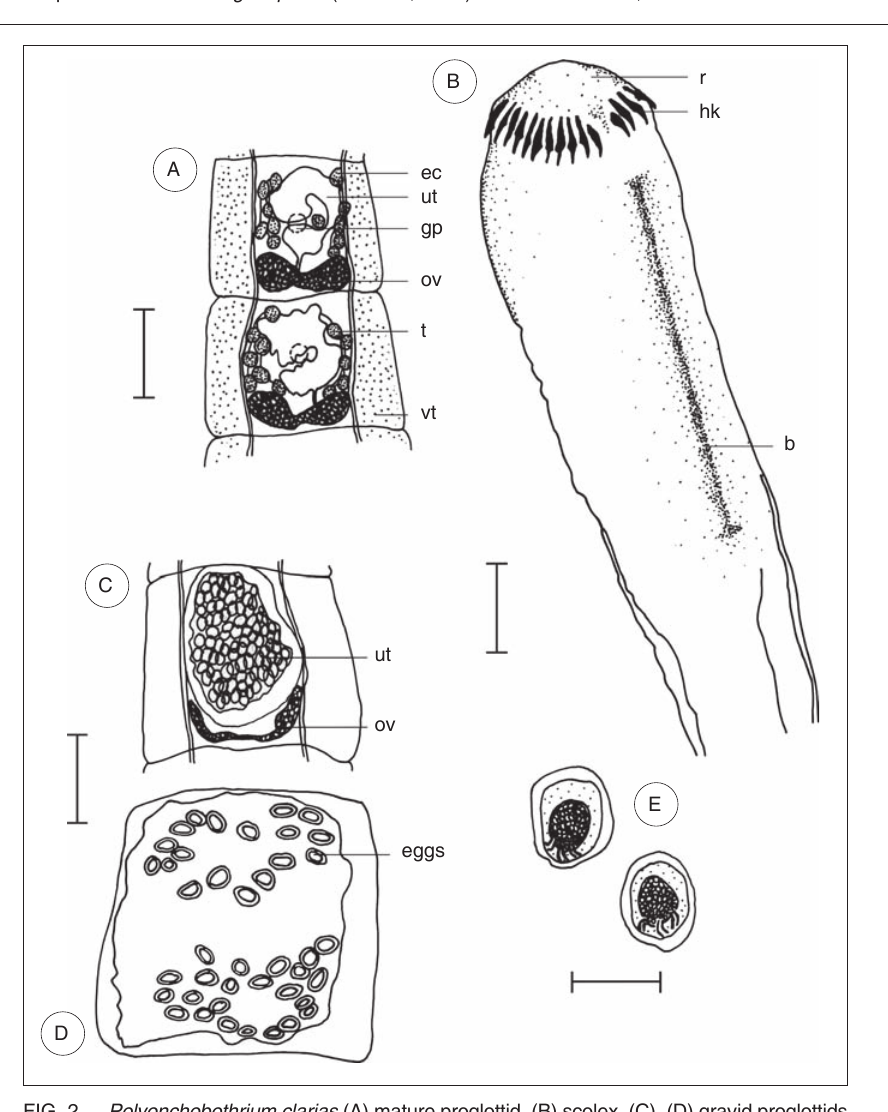
FIG. 2 Polyonchobothrium clarias (A) mature proglottid, (B) scolex, (C), (D) gravid proglottids (scale bar = 200 μ m), (E) eggs (scale bar = 50 μ m), b = bothrium, ec = excretory canal, gp = genital pore, hk = hook, ov = ovary, r = rostellum, t = testis, ut = uterus, vt = vitel